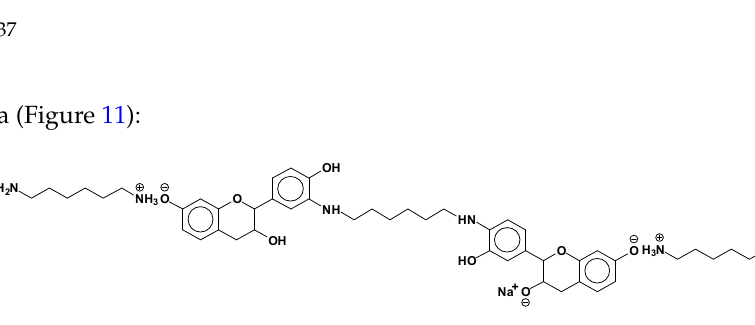
Figure 11. Example of covalent bonds dimer mixed with ionic salt bonds at 880 Da. At 1070 Da (Figure 12):